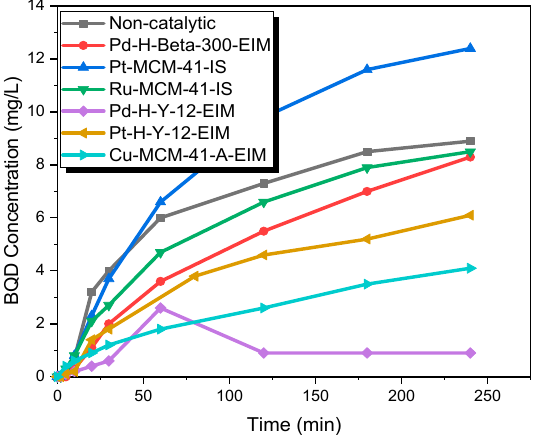
Figure 11. BQD concentration during the catalytic and non-catalytic ozonation of CBZ. C CBZ = 35 mg/L, gas flow rate = 110 mL/min, T = 50 °C, stirring speed = 900 rpm, C O3,g = 21 mg/L, C catalysts = 0.5 g/L.